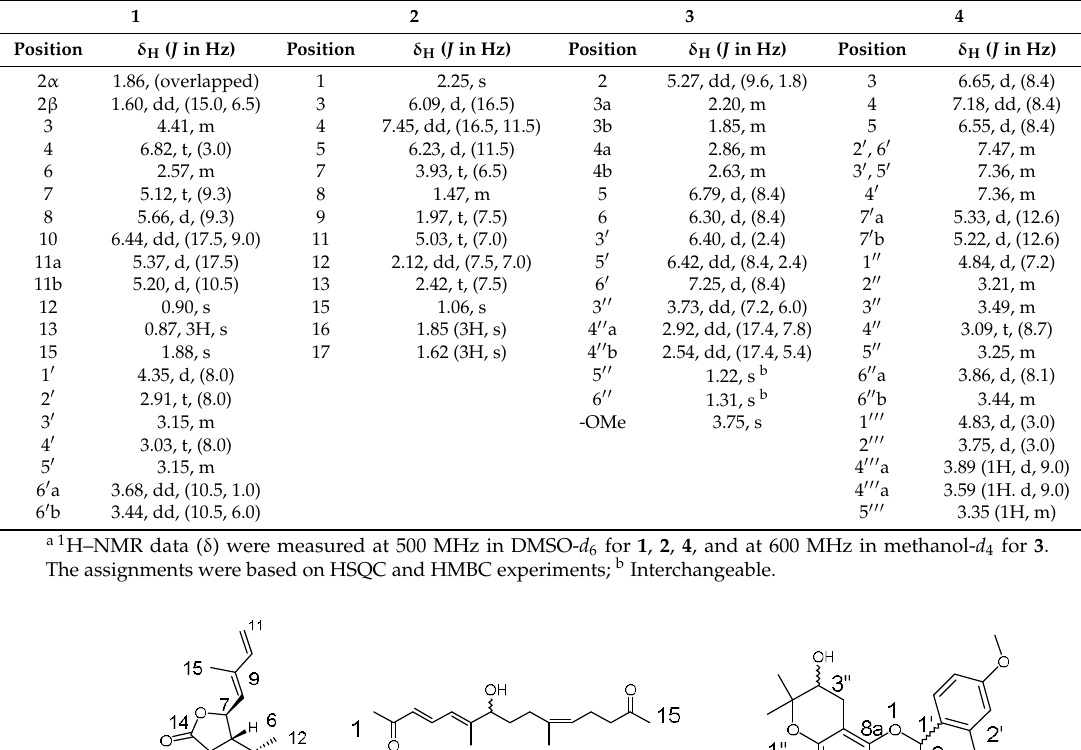
Table 1. 1 H-NMR Spectroscopic Data of Compounds 1 – 4 a .